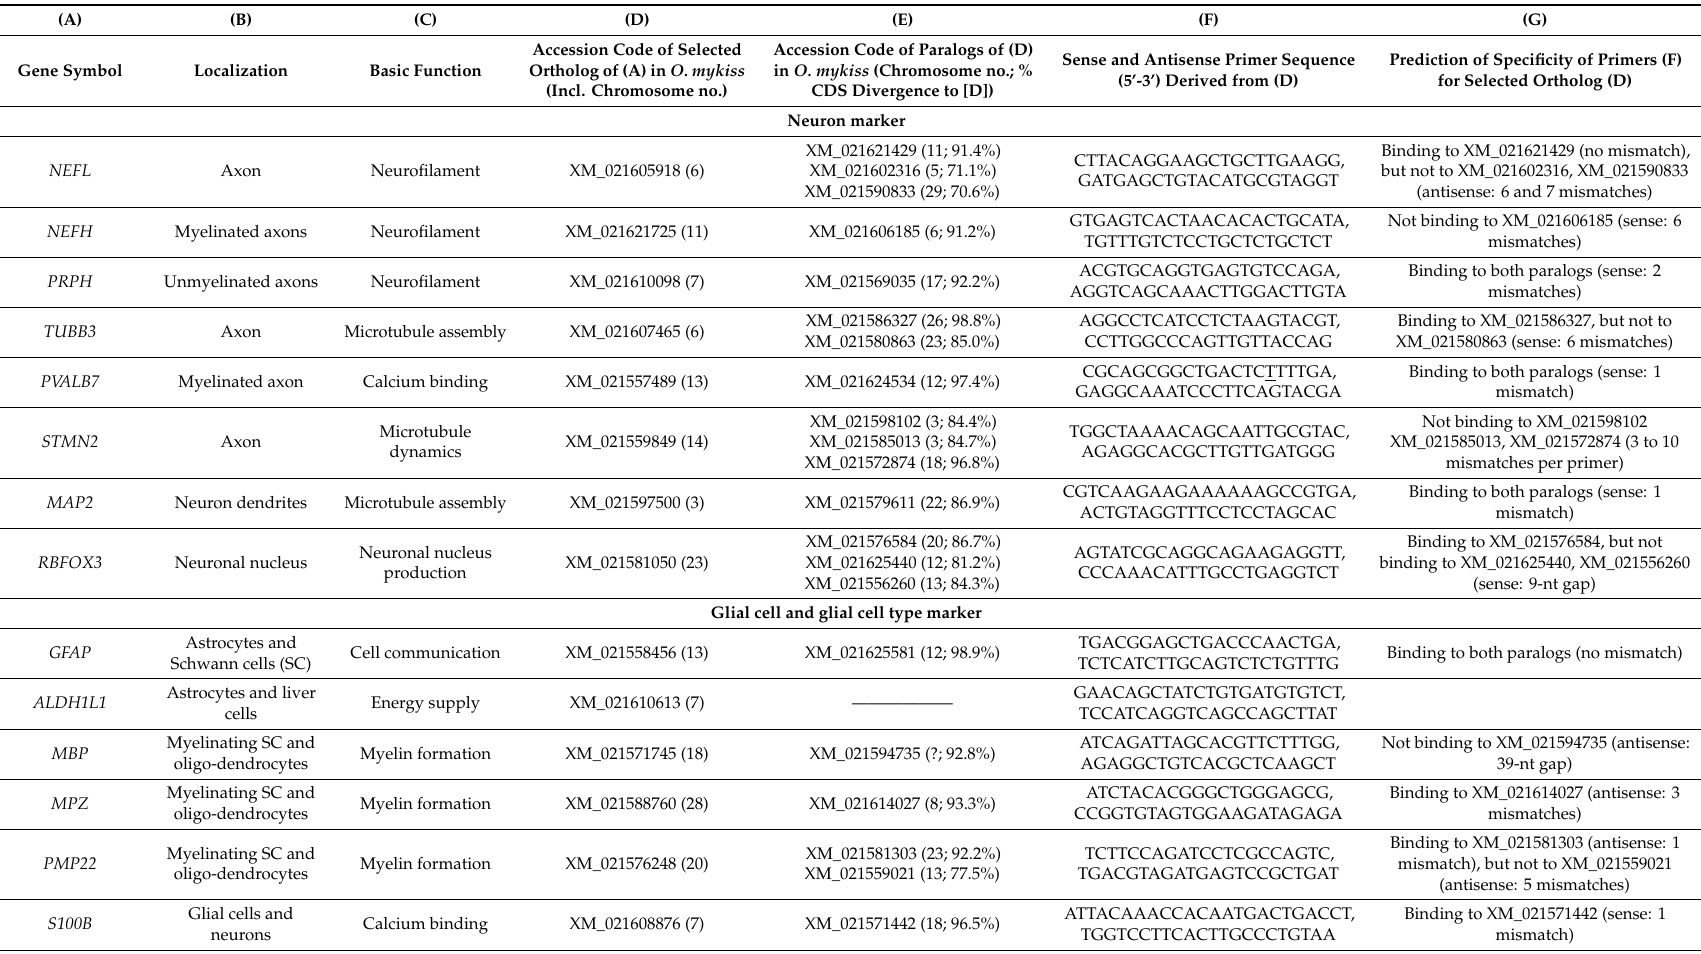
Table A1. Primer assays used in the present